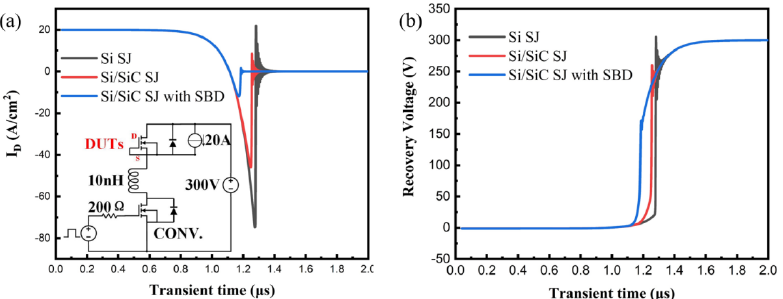
Figure 3. Reverse recovery waveforms of body diodes of three SJ MOSFETs and the simulation circuit; ( a ) Reverse recovery current of three studied SJ MOSFET ( b ) Reverse recovery voltage of three types of SJ